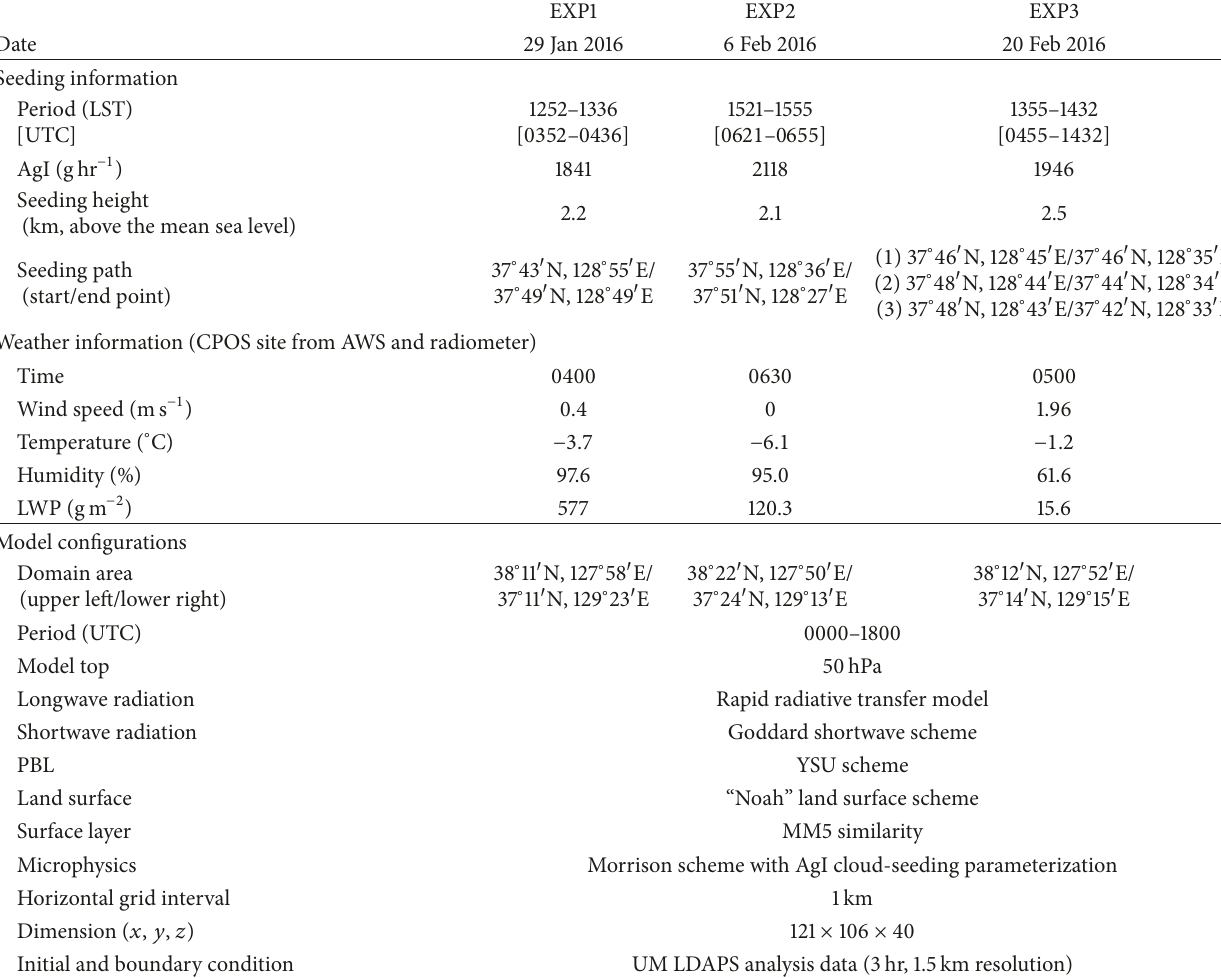
Table 1: Summary of the seeding information, weather conditions, and model